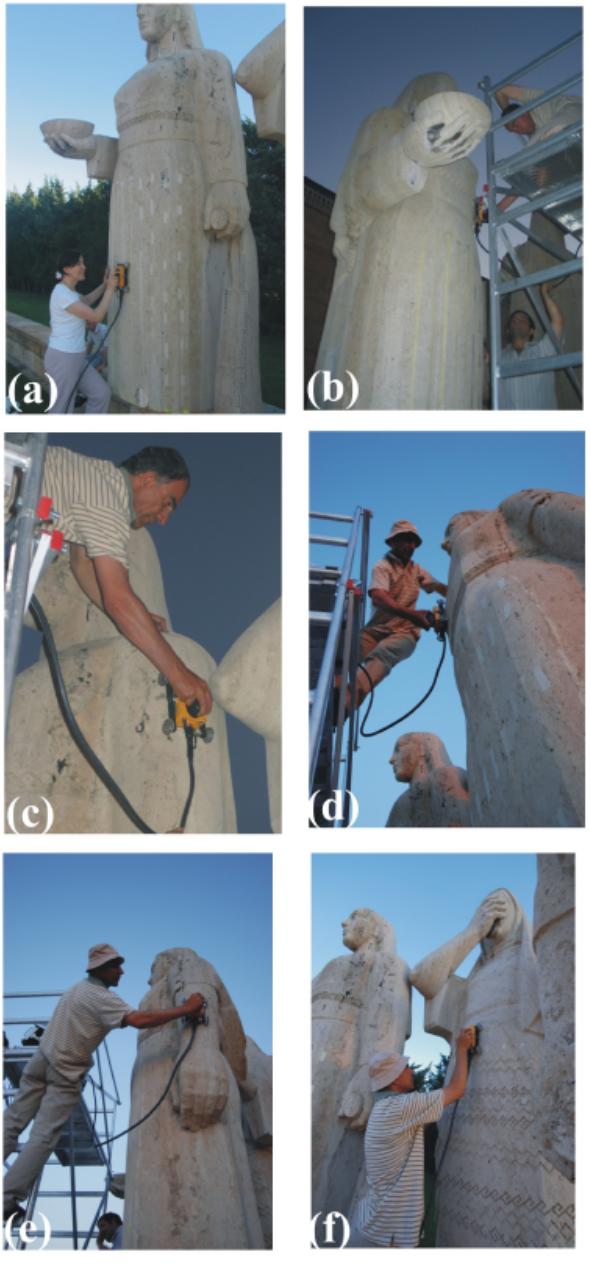
Fig. 4. Data acquisitions of the first woman statue (a) on the skirt, (b) between the waist and the neck, (c) on the left arm, (d) data acquisition of the second woman statue between the waist and the neck and (e) on the left arm, (f) on the skirt of the third woman